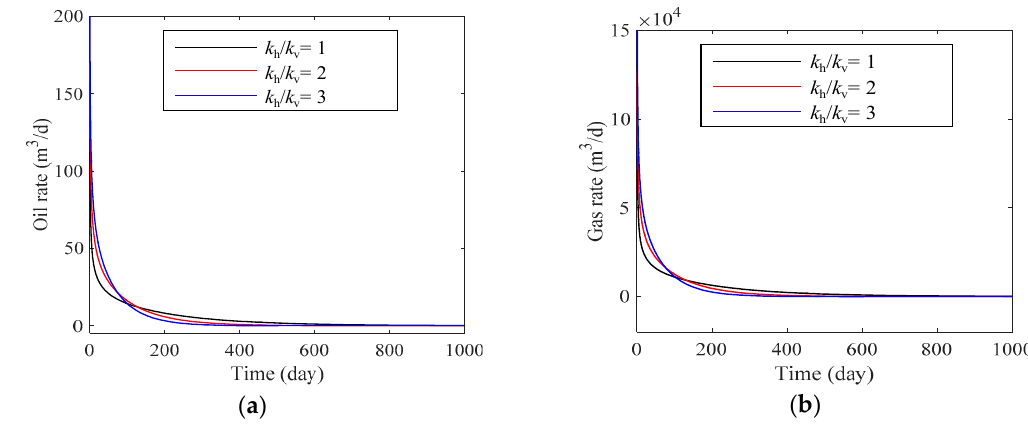
Figure 12. Effect of permeability ratio on production rate: ( a ) effect of permeability ratio on oil production rate; ( b ) effect of permeability ratio on gas production rate.